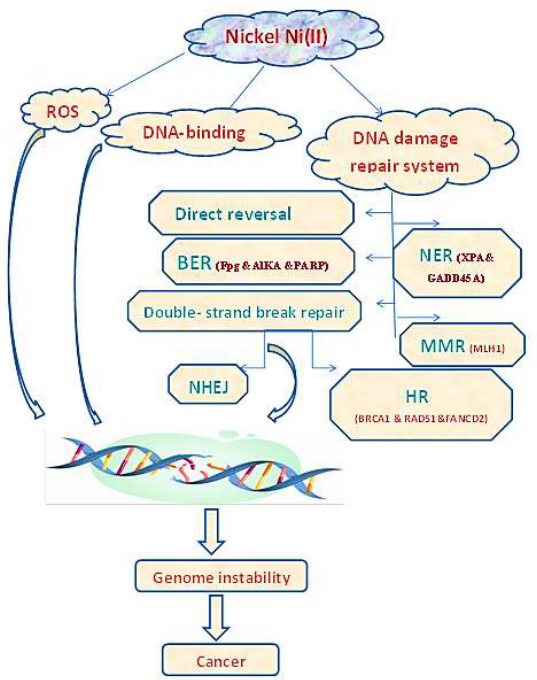
Figure 3. A simplified model of Ni-induced DNA damage in the onset of cancer. Excessive expo- sure to Ni can induce DNA damage, mainly through direct DNA binding and ROS generation. Ni can also repress the DNA damage-repair pathways, including direct reversal, BER, NER, MMR, HR, and NHEJ repair. DNA damage causes genome instability that may ultimately contribute to cancer. Reproduced from the permission of ref.